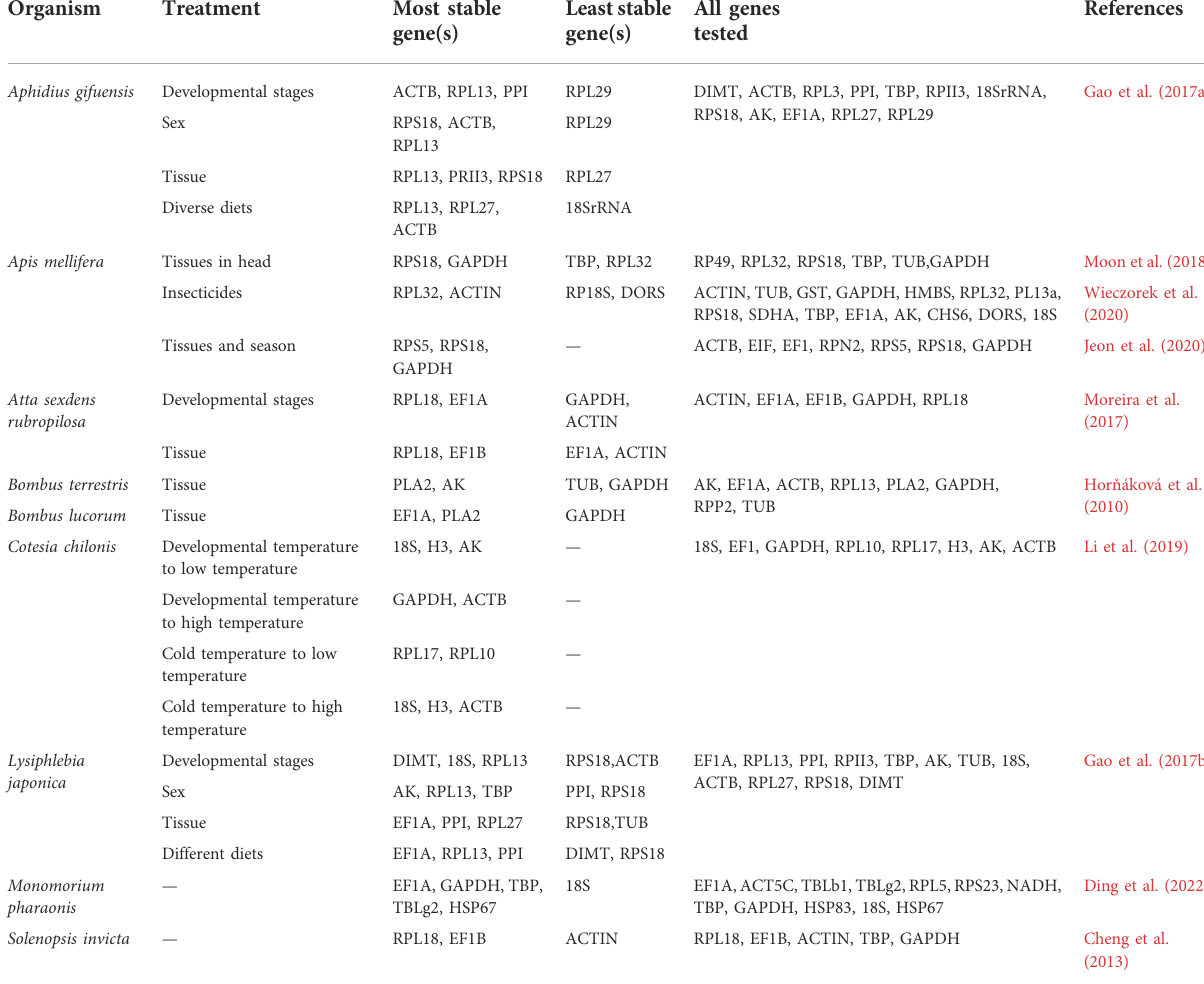
TABLE 3 Summary of the stability rankings of reference genes from studies conducted in